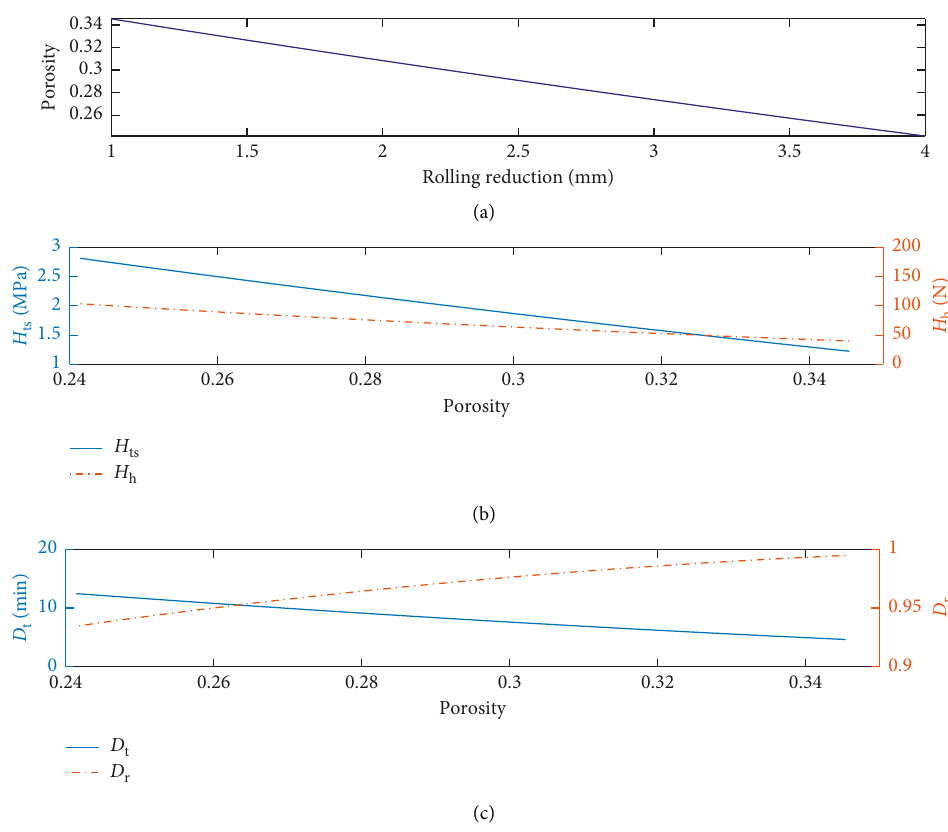
Figure 11: The experimental results for tabletting: the influences of rolling reduction.